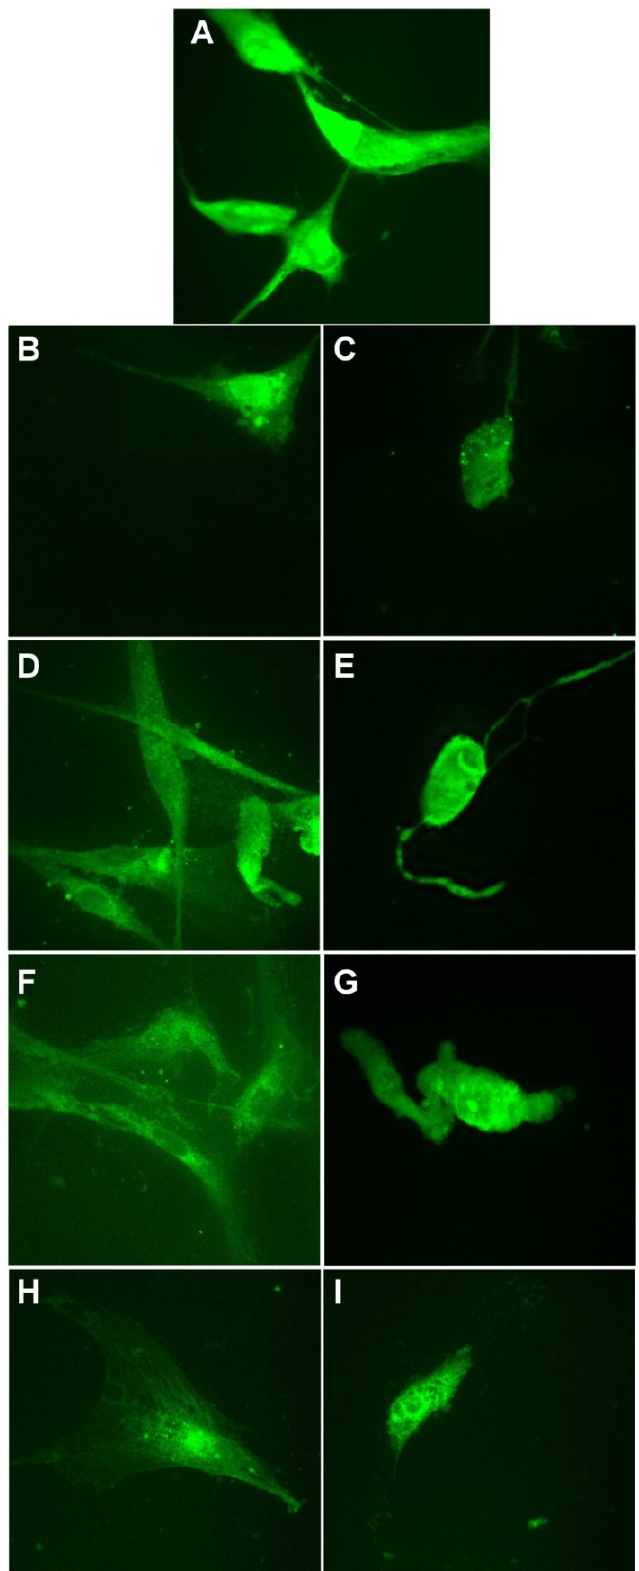
Figure 12. Morphological evaluation of BJ cells treated with Tur-nAg/AgCl ( B , C ), Tur-nAg/AgCl–Lip ( D , E ), Tur-nAg/AgCl–CTS ( F , G ), and Tur-nAg/AgCl–Lip–CTS ( H , I ) at two different concentrations: 12.8 mg/mL and 51.1 mg/mL, respectively, compared with control cells ( A ).